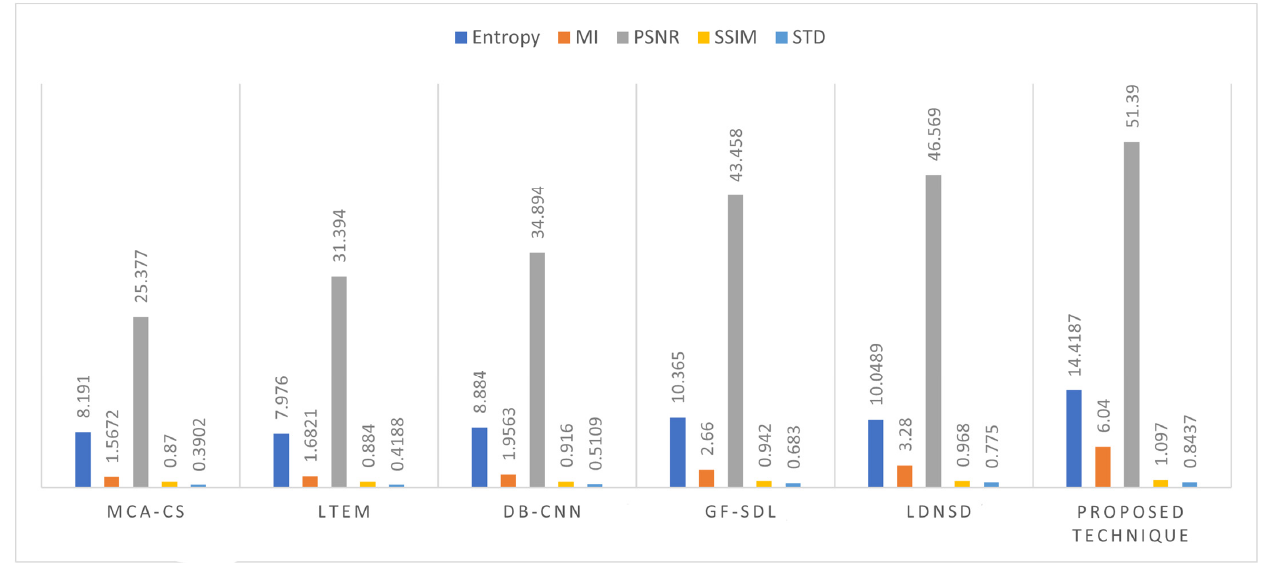
Figure 9. Results of MR-PET image fusion simulation ( a ) MR input, ( b ) PET input ( c ) MCA-CS [14],